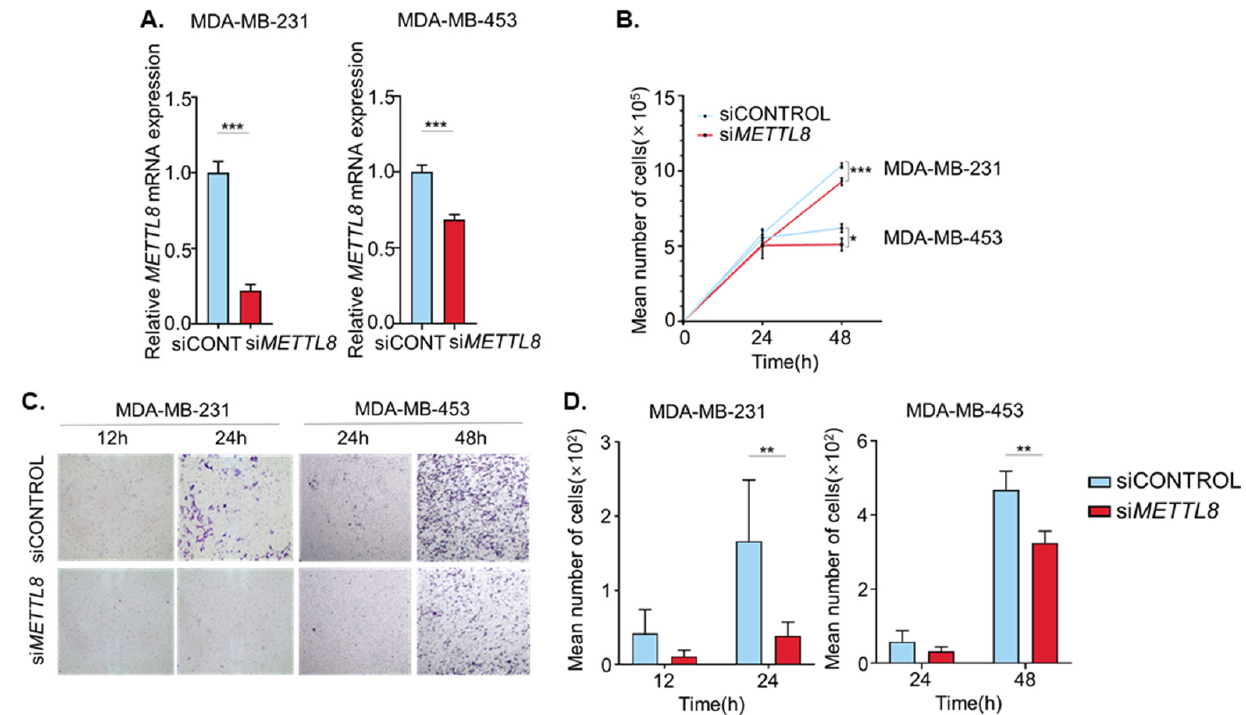
Figure 3. ( A ) Knockdown efficiencies of METTL8 in both MDA-MB-231 and MDA-MB-453 cell lines were verified by RT-qPCR. ( B ) Cell proliferation of METTL8 knockdown cells and negative control was assessed by cell counting. ( C , D ) Cell migration of METTL8 knockdown cells and negative control cells were measured by transwell assay. * indicates p < 0.05, ** p < 0.01 and *** p < 0.001.